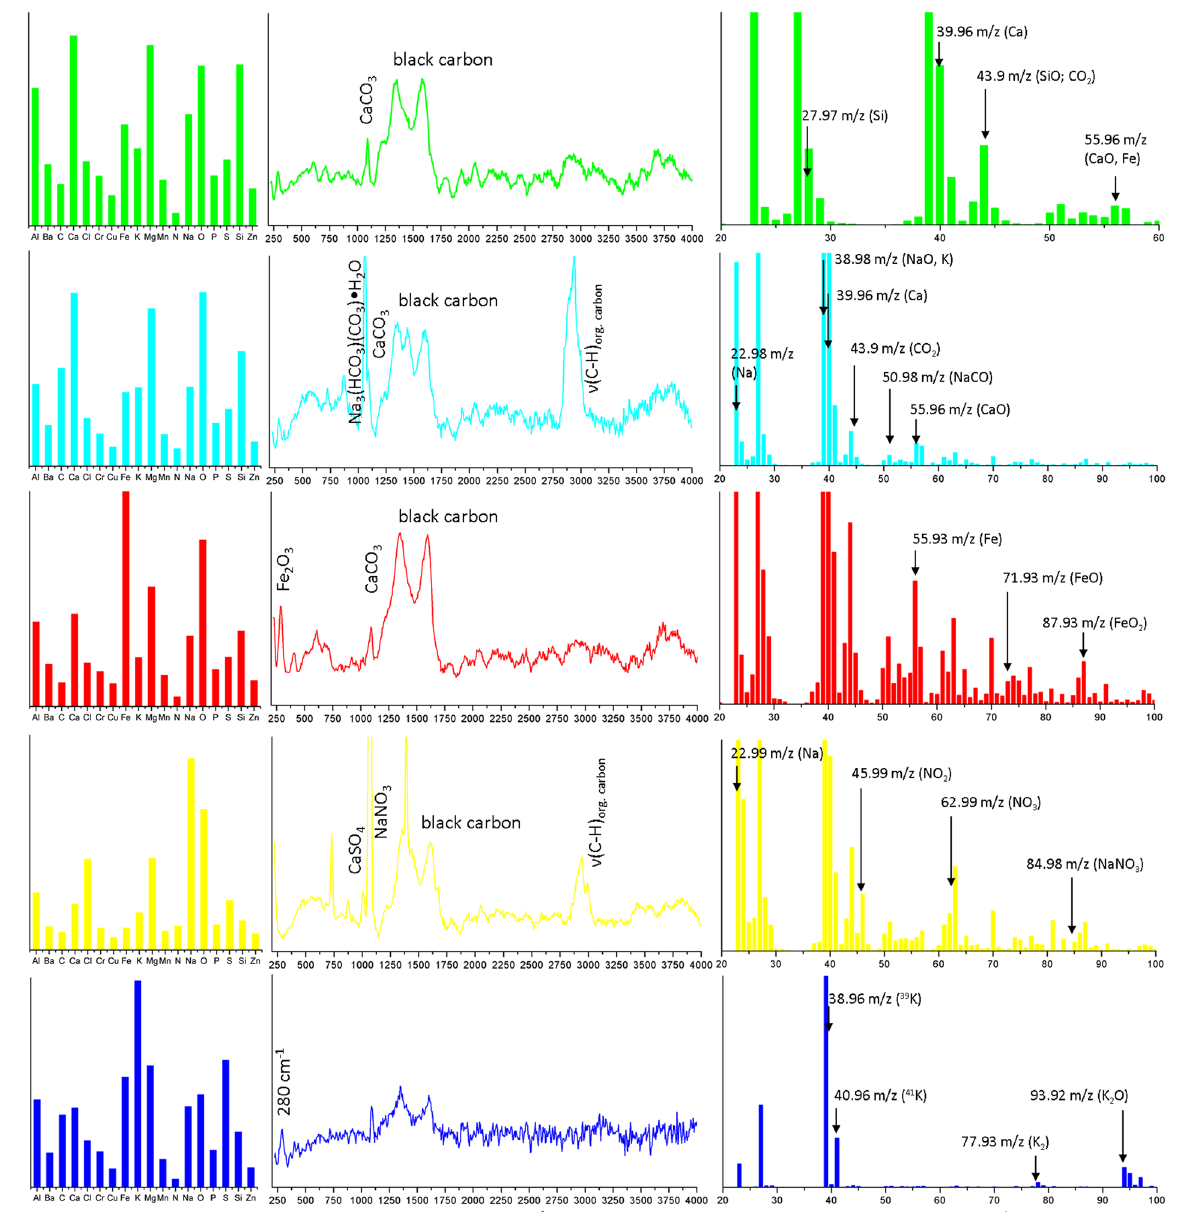
Figure 6. Examples of extracted sub-cluster spectra from the HCA of the environmental aerosol sample and assignment of spectral